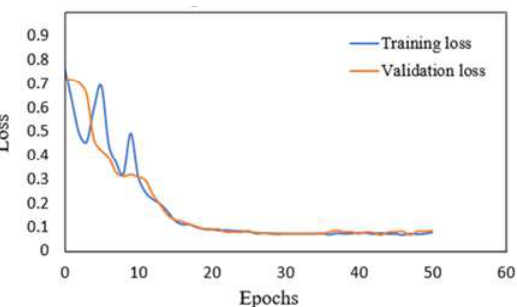
Figure 2. Plot depicting training (blue line) and validation (orange line) losses